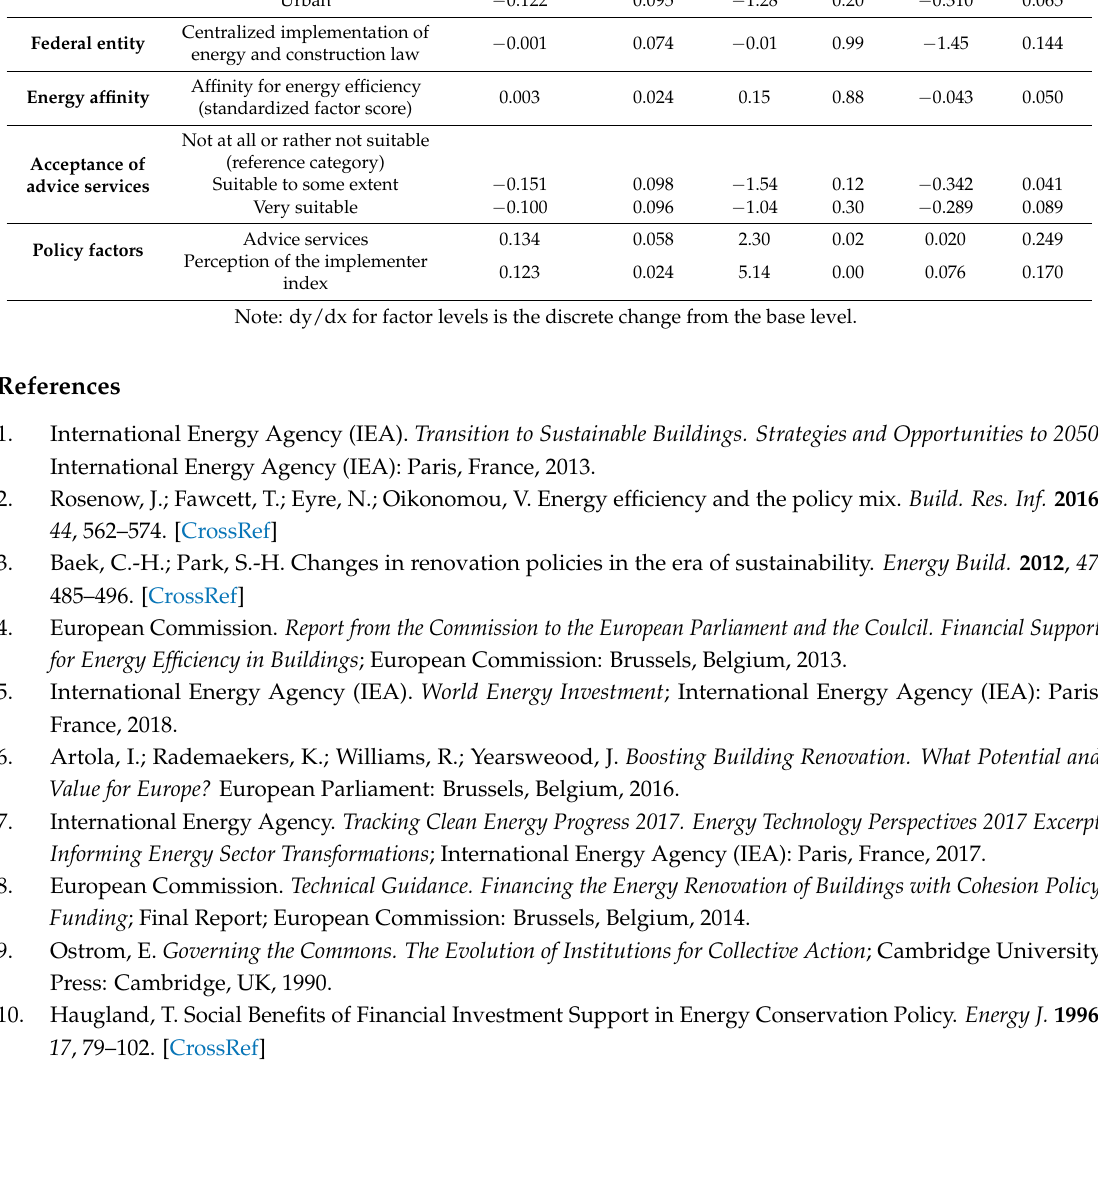
Marginal Effects